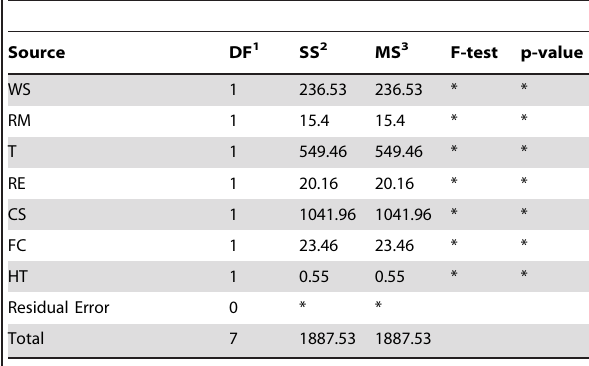
Table 5. Analysis of Variance for means for the filtration improvement